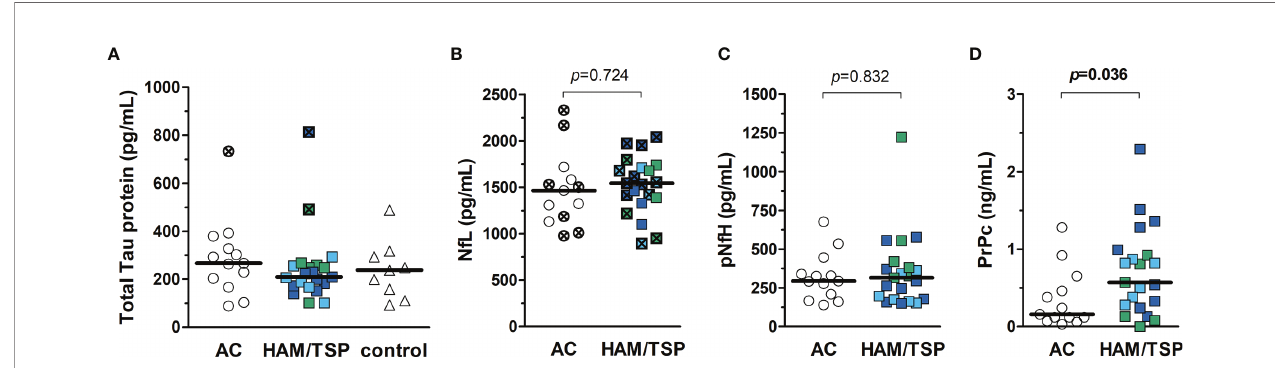
FIGURE 3 | Biomarkersofneurodegeneration inthe CSF of HTLV-1-infected individuals. (A) Total Tau protein, (B) neuro fi lament light chain(NfL), (C) phosphorylated neuro fi lament heavy chain, and (D) cellular prion protein (PrPc) were quanti fi ed byELISA in the CSFof HTLV-1 asymptomatic carriers(AC)(n= 13) andHAM/TSP patients (n = 21). (A) A control groupof HTLV-1 seronegativeindividuals (n = 9) was included,and the comparison between groups was performed by Kruskal-Wallistest with Dunn ’ s post-test for multiple comparisons. (B – D) Statistical analysis was performed with Mann-Whitney test. A p -value< 0.05 was considered signi fi cant. HAM/TSP patients were identi fi edaccording to the speed of disease progression as veryslow (light blue), typical/slow (darkblue) and rapid(green). Individualswith altered levelsof total Tau protein andNfL according to age-corrected reference values are shown with boldsymbolsmarked with an ×. Reference values for NfL in CSF de fi ned byJessen Krut et al.(30):18- 30 years, < 380 pg/mL;30-39 years, < 560 pg/mL;40-59 years, < 890 pg/mL;> 59 years-old,< 1850 pg/mL.Reference values for totalTau protein determined bySjögren et al.(46):21-50 years, < 300 pg/mL;51-70 years, < 450 pg/mL; 71-93 years, < 500